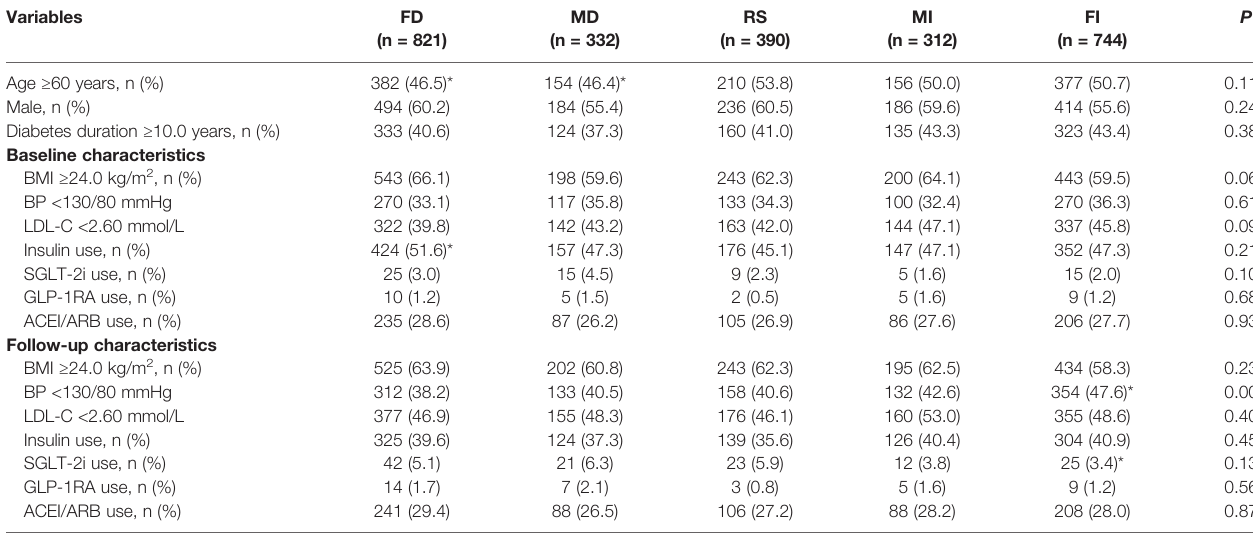
TABLE 3 | Demographic and clinical characteristics for the fi ve different eGFR change groups. Variables FD